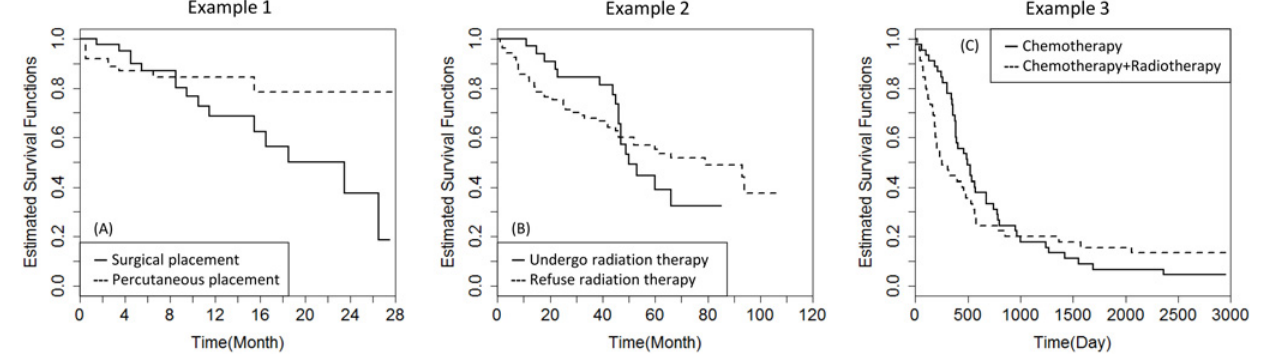
Figure 2. Estimated survival functions for Example 1, 2, and 3.